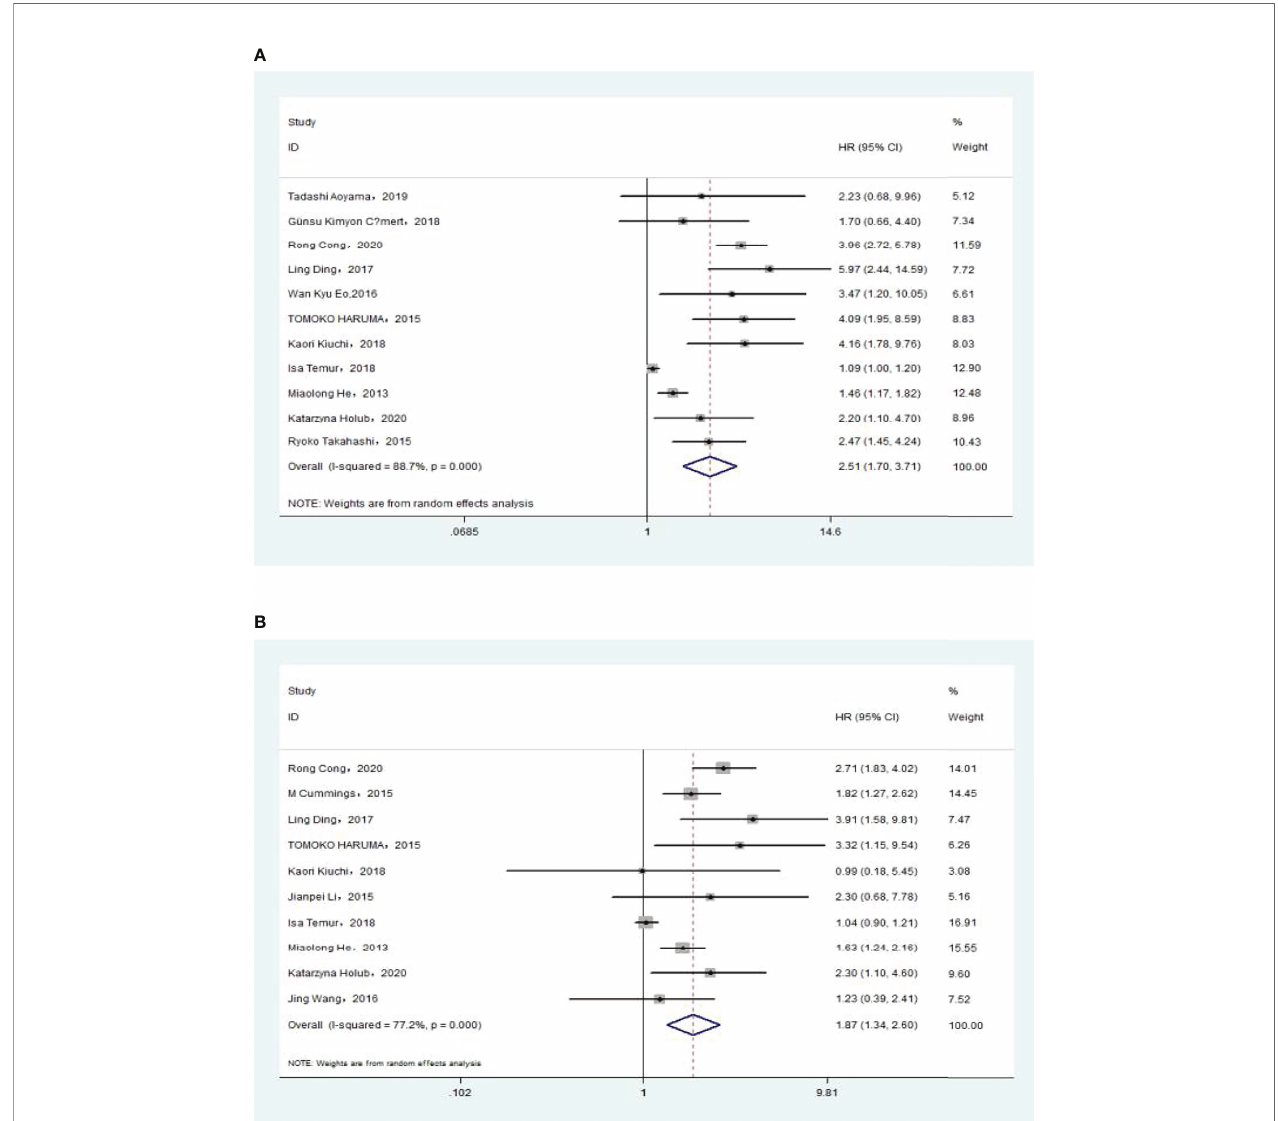
FIGURE 2 | (A) Relationship between neutrophil – lymphocyte ratio ( NLR) and overall survival in univariate analysis. (B) Relationship between NLR and overall survival in multivariate analysis.